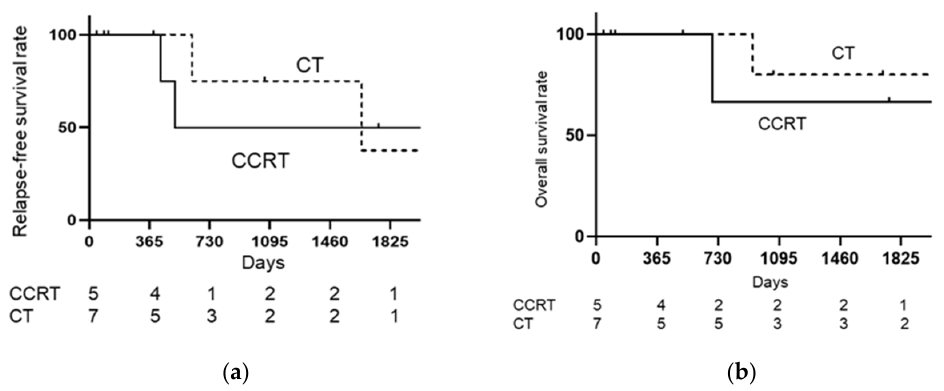
Figure 4. Kaplan–Meier analysis of relapse-free survival (RFS) and overall survival (OS) with pathological parametrium invasion. ( a ) Kaplan–Meier analysis of relapse-free survival (RFS) with pathological parametrium invasion; ( b ) Kaplan–Meier analysis of overall survival (OS) with pathological parametrium invasion. The CCRT with pathological parametrium invasion group is compared with the chemotherapy with pathological parametrium invasion group; there are no significant differences in RFS (log-rank: p = 0.8087, HR: 0.7872, 95%CI: 0.1093–5.668) and OS (log-rank: p = 0.6084, HR: 0.4933, 95%CI: 0.0259–9.394) between them. As shown in Table 2, the recurrence rate of the CCRT group was 26.3%, and the recurrence rate of the CT group was 33.3%. The recurrence rate was not significantly different between the CCRT and CT groups ( p = 0.7365). In the CCRT Group, 4 patients recurred outside the pelvis, and 1 patient recurred both in the pelvis and outside the pelvis. In the CT group, 1 patient recurred in the pelvis, 3 patients recurred outside the pelvis, and 3 patients recurred both in the pelvis and outside the